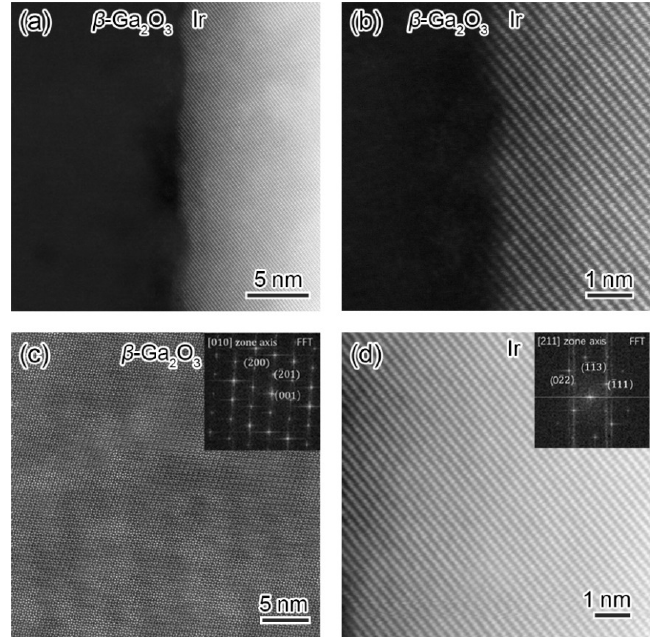
Figure 4. ( a ) Atomic-resolution HAADF-STEM image of the β -Ga 2 O 3 /Ir interface. ( b ) The corresponding magnified HAADF-STEM image of the region in ( a ), showing small fluctuations at the nanoscale. ( c ) Cross-sectional HAADF-STEM image of the Ga 2 O 3 phase from dark region in ( a ) recorded along the [010] projection direction. ( d ) Cross-sectional HAADF-STEM image of the Ir phase from bright region in ( a ) recorded along the [211] projection direction.